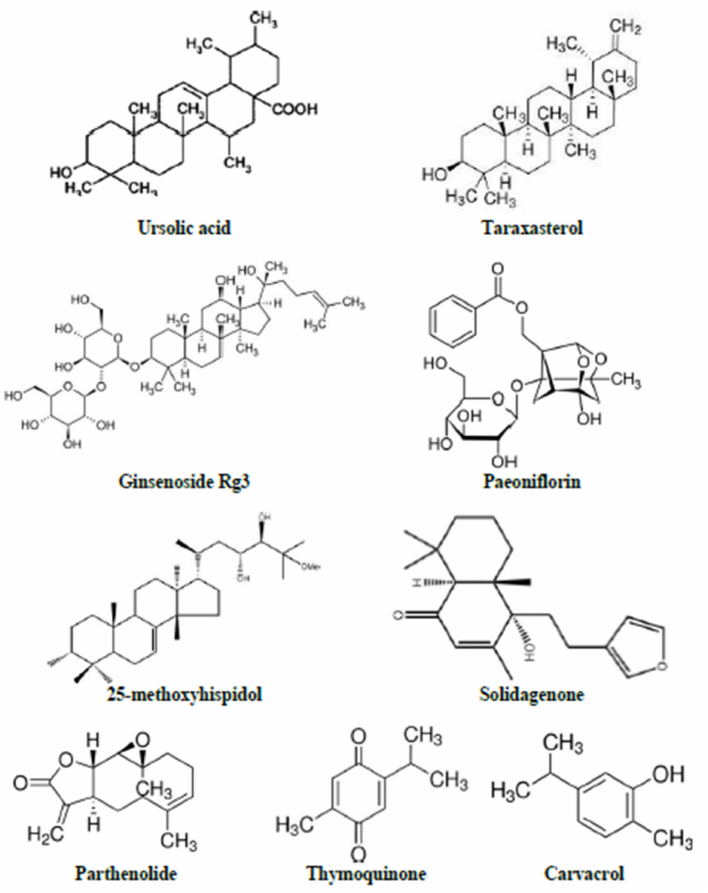
Figure 6. Terpenes or terpenoids compounds effective against LPS-induced sickness behaviour in